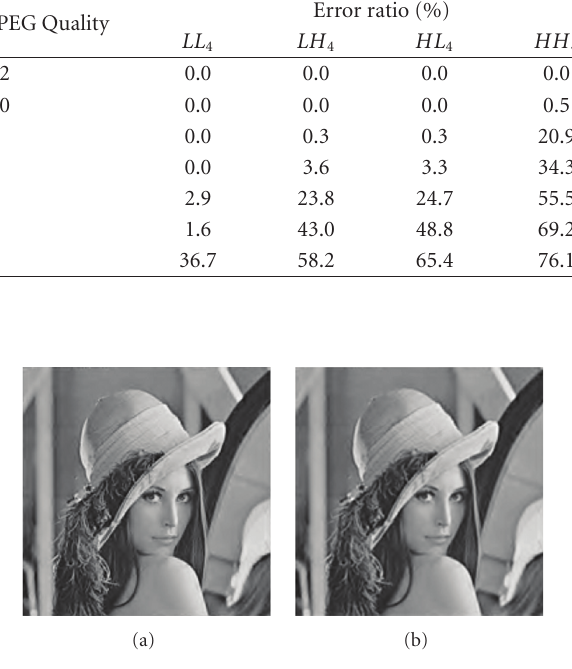
Figure 2: JPEG2000 watermarking example for Lena image: (a) before, (b) after